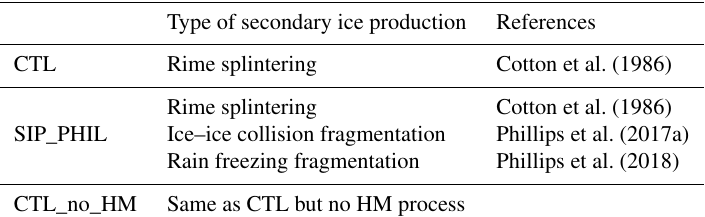
Table 1. List of